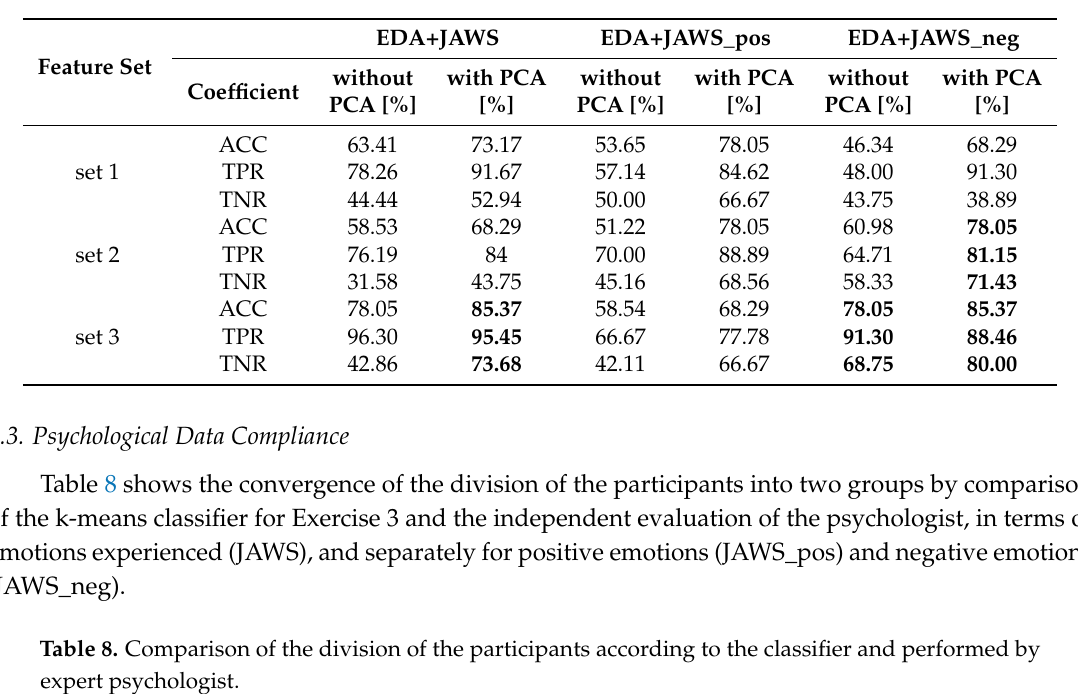
Table 7. Evaluation of the k-means classifier for individual sets of features.